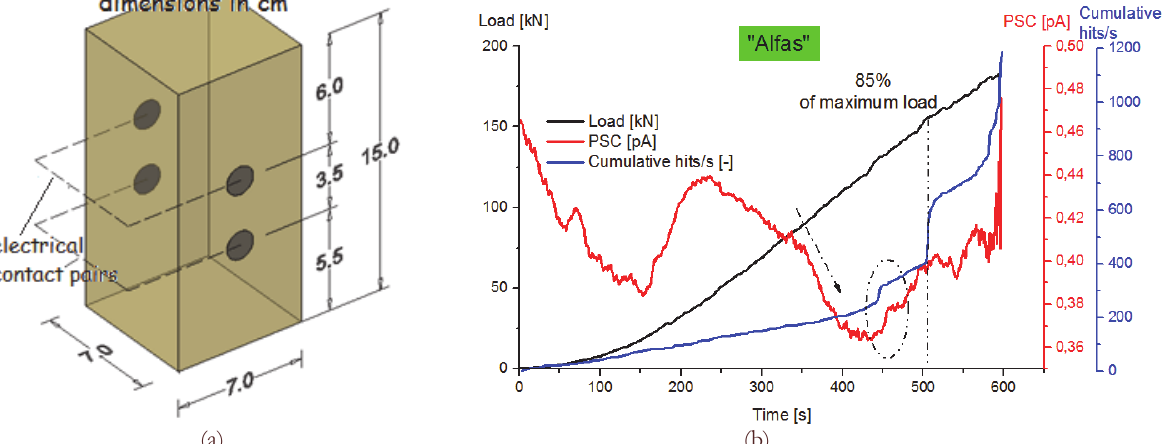
Figure 13: (a) A typical prismatic specimen made of Alfas stone subjected to uniaxial compression and (b) the respective time variation of load, cumulative hits/s and Pressure Stimulated Currents